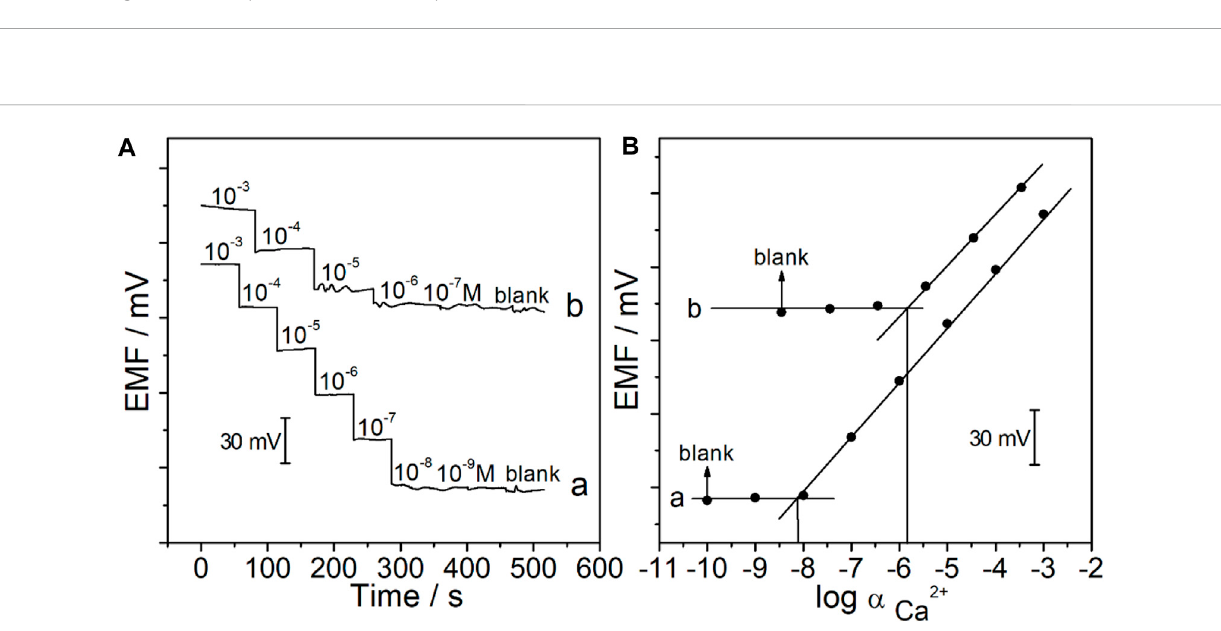
FIGURE 4 Impedance spectra for the bare CF μ Es ( ○ ) and the CF μ Es modi fi ed with the PEDOT (PSS) fi lm ( C ) (A) and the Ca 2+ -IS μ E (B) in 0.1 M KCl solution at theopen-circuit potential. Frequency range: 0.01 Hzto10 kHz; excitation amplitude: 100 mV. In theinset ofFigure 4B,R 1 isthesolution resistance, Z D is the fi nite-length diffusion impedance, and R 2 is the parallel